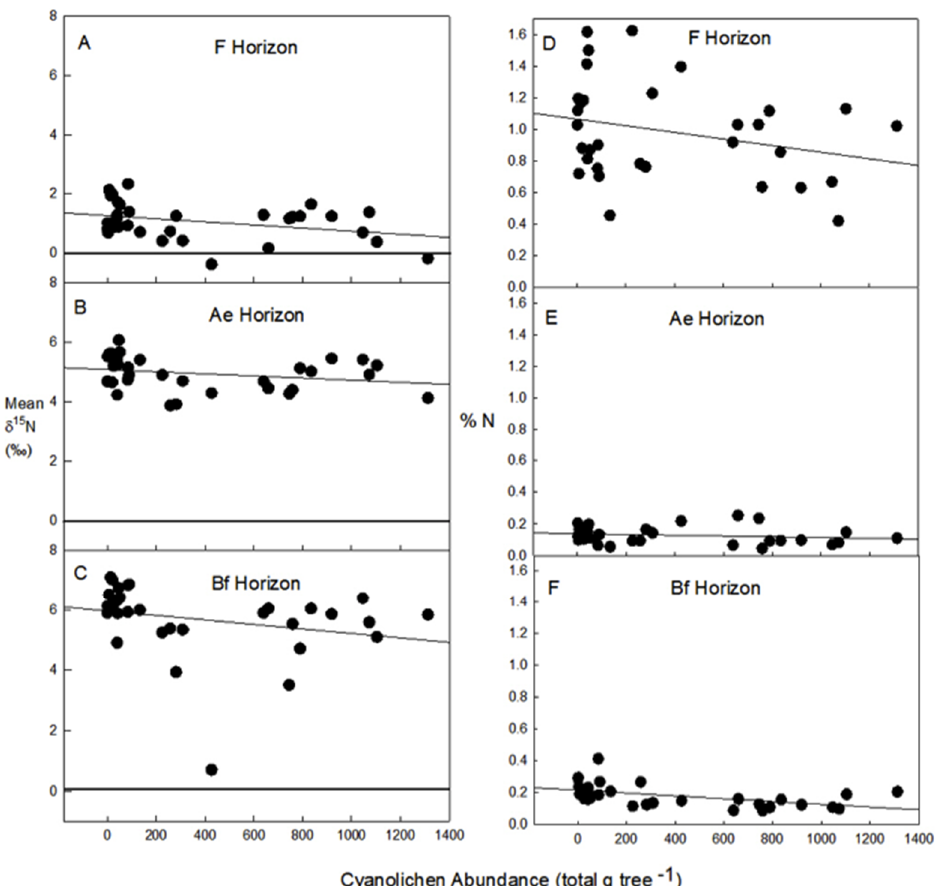
Figure 4. Mean δ 15 N and %N of (A and B) the surface organic F horizons, (B and E) upper-most mineral (Ae) horizons and (C and F) lower mineral (Bf) horizons, respectively, beneath host trees with varying levels of cyanolichen abundance (total g tree − 1